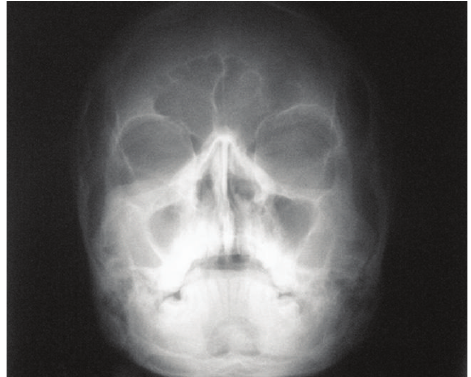
Figure 7: PA Water’s view shows haziness with decrease in size of the right maxillary